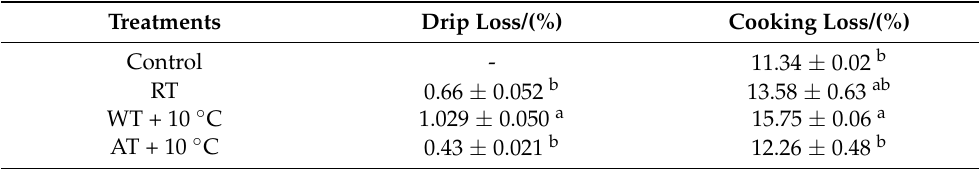
Table 3. Effects of different tempering methods on drip loss and cooking loss of salmon. (RT: Radio frequency tempering; WT + 10 ◦ C: Water tempering at 10 ± 0.5 ◦ C; AT + 10 ◦ C: Air tempering at 10 ± 1 ◦